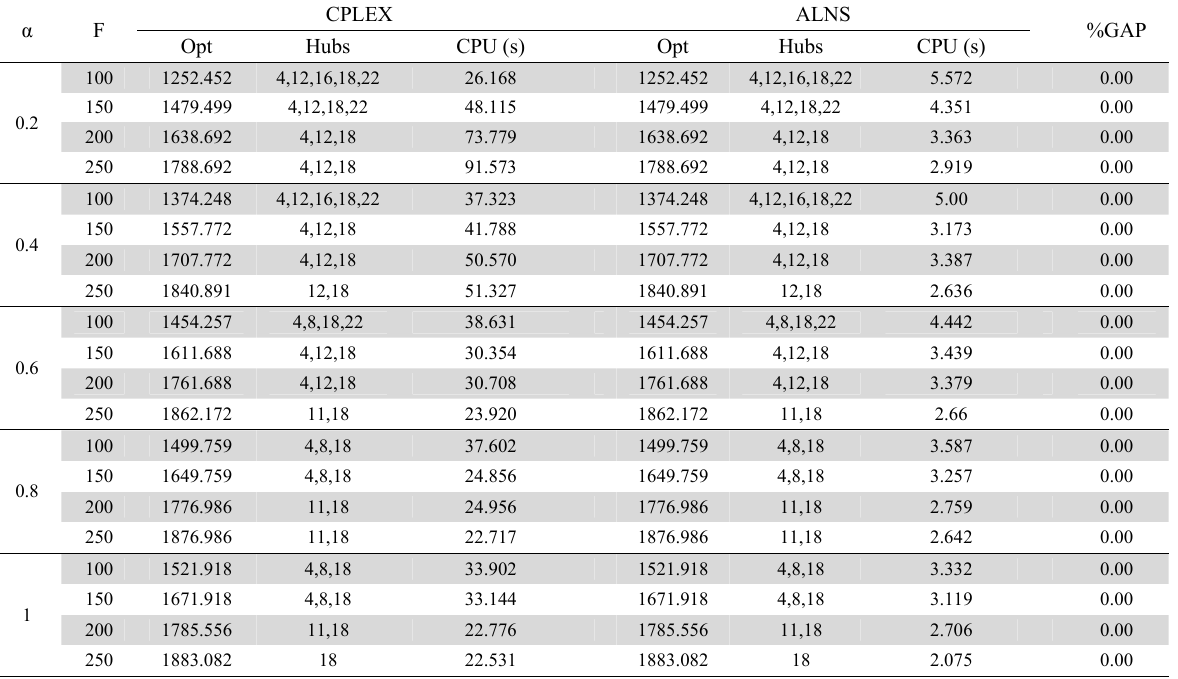
Results for the CAB data set with θ =